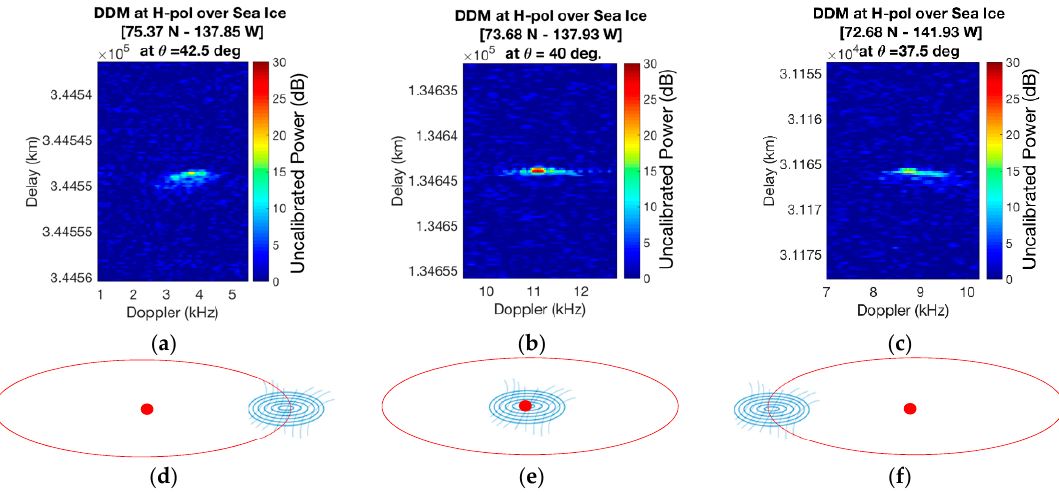
Figure 9. Delay–Doppler Maps of the scattered power measured by SMAP-R for ( a ) ocean surface in the edges of the Caribbean Sea between Puerto Rico and Caracas, ( b ) arid land surface in the middle of Australia, near the Neale Junction Nature Reserve, and ( c ) sea ice surface in the Kara Sea, Russia.